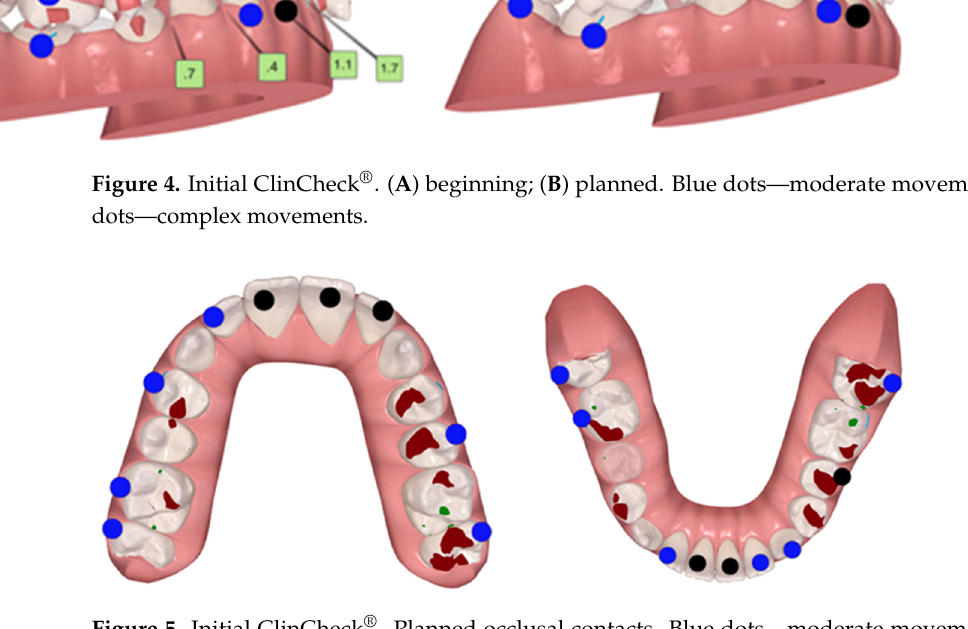
Figure 5. Initial ClinCheck ® . Planned occlusal contacts. Blue dots—moderate movements; black dots—complex movements.